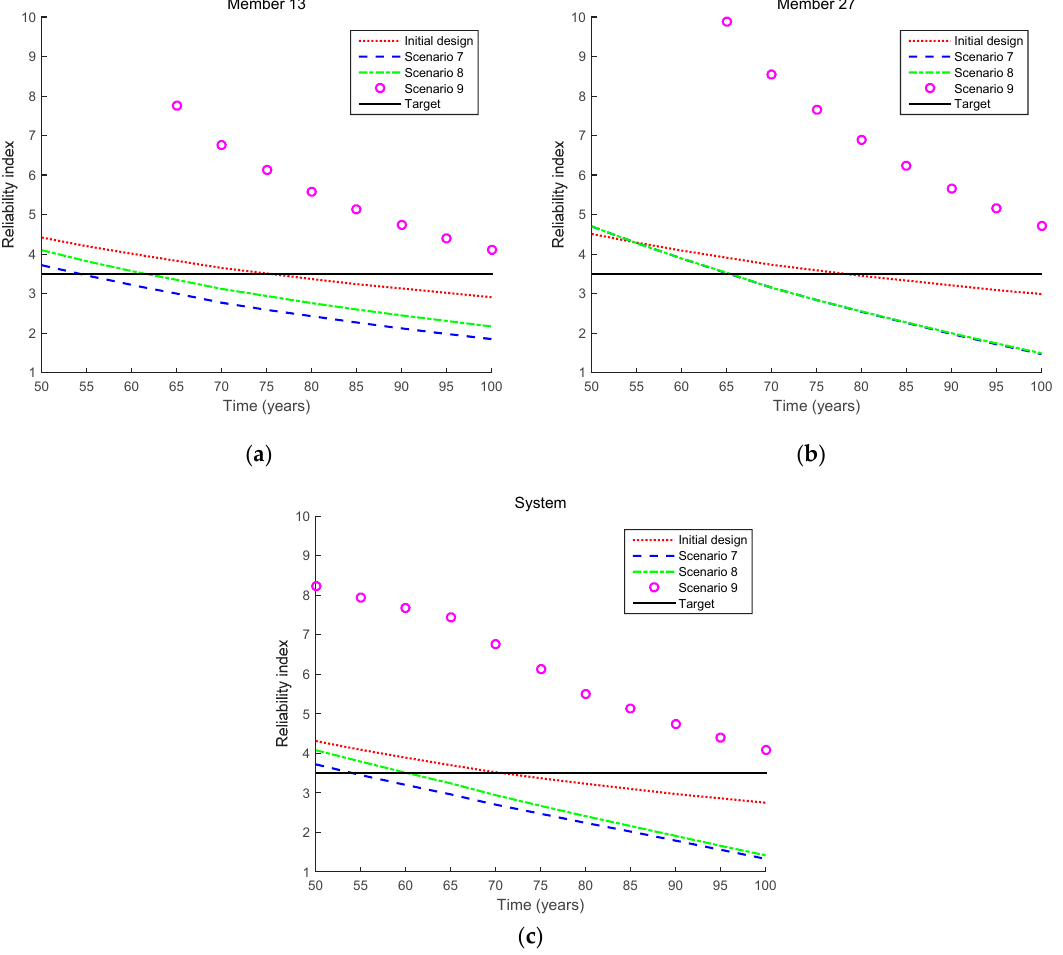
Figure 12. Comparison of updated reliability indices for equality cases (Scenarios 8 and 9 in Table 3). (a) Member 13; (b) Member 27; (c) System. Table 6. Fatigue lives for mixed cases (Scenarios 8 and 9 in Table 3).